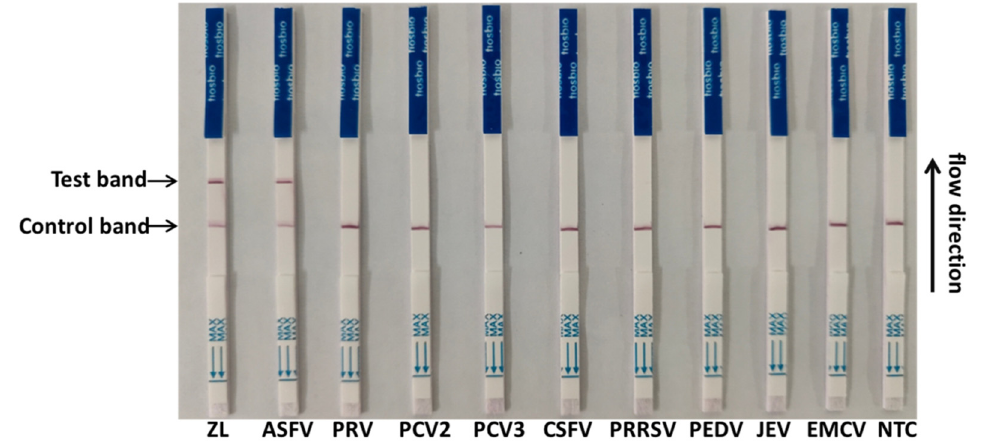
Figure 4. Specificity test of the CRISPR/Cas13a-LFD. Four DNA viruses (African swine fever virus (ASFV), pseudorabies virus (PRV), porcine circovirus 2 (PCV2), and PCV3) and five RNA viruses (classical swine fever virus (CSFV), porcine reproductive and respiratory syndrome (PRRSV), porcine epidemic diarrhea virus (PEDV), Japanese encephalitis virus (JEV), and encephalomyocarditis virus (EMCV)) were tested.